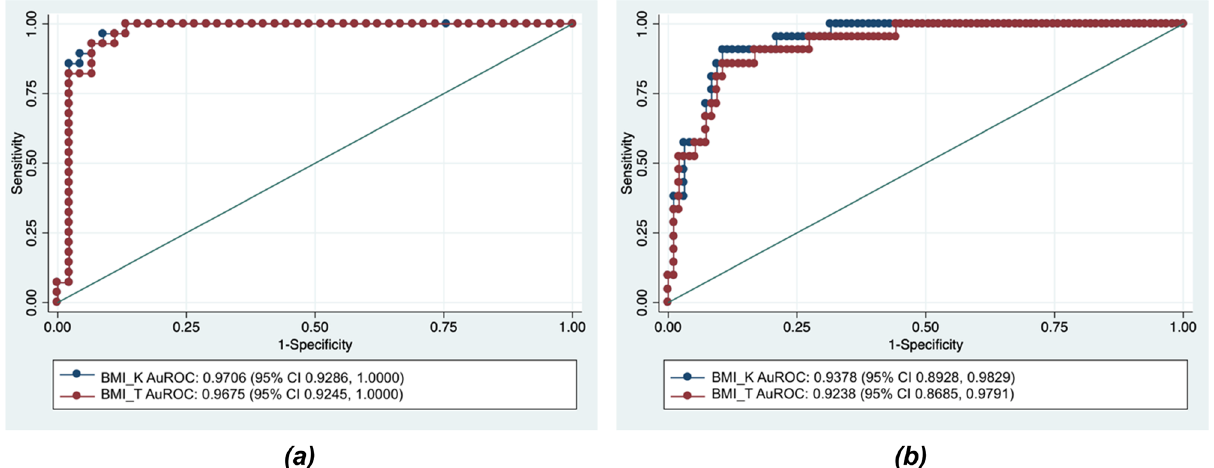
Figure 2. Receiver-operator characteristic (ROC) curves with corresponding areas under the curves (AuROCs) for BMI K and BMI T among males (a) and females (b) . The 95% CIs are indicated in parentheses. BMI T proposed modified (Trefethen) BMI, BMI K traditional Quetelet